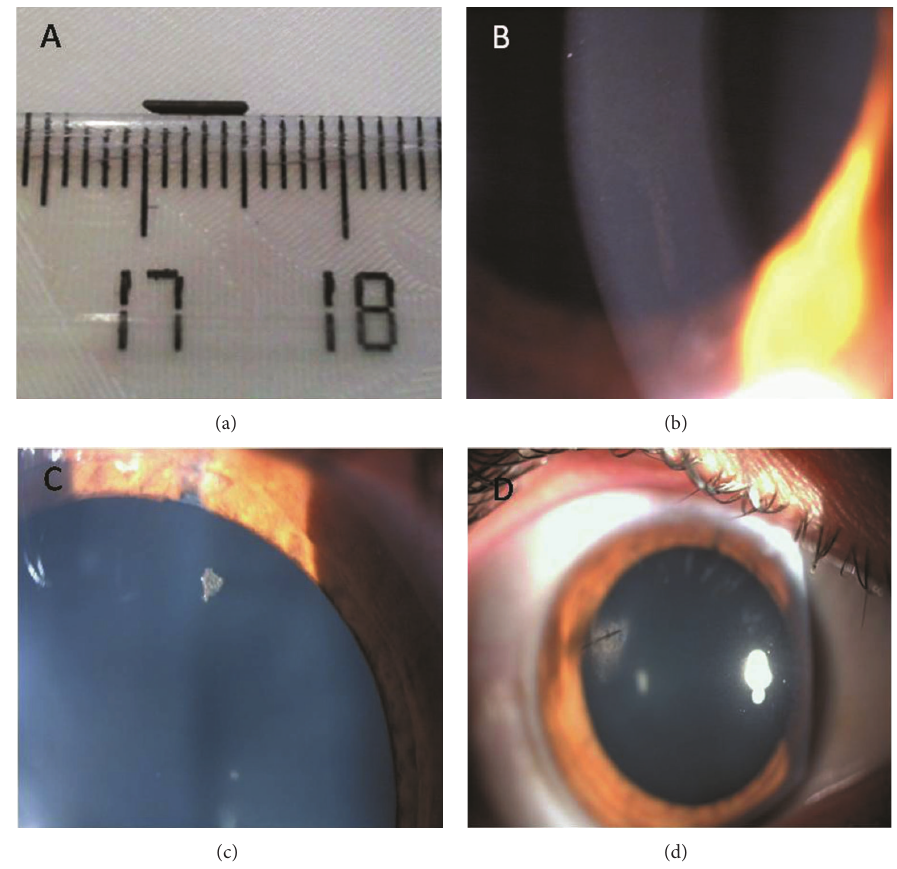
Figure 1: (a) Removed foreign body; (b) endothelial deposits; (c) graphite on the lens in first day; (d) corneal deposits were resolved.